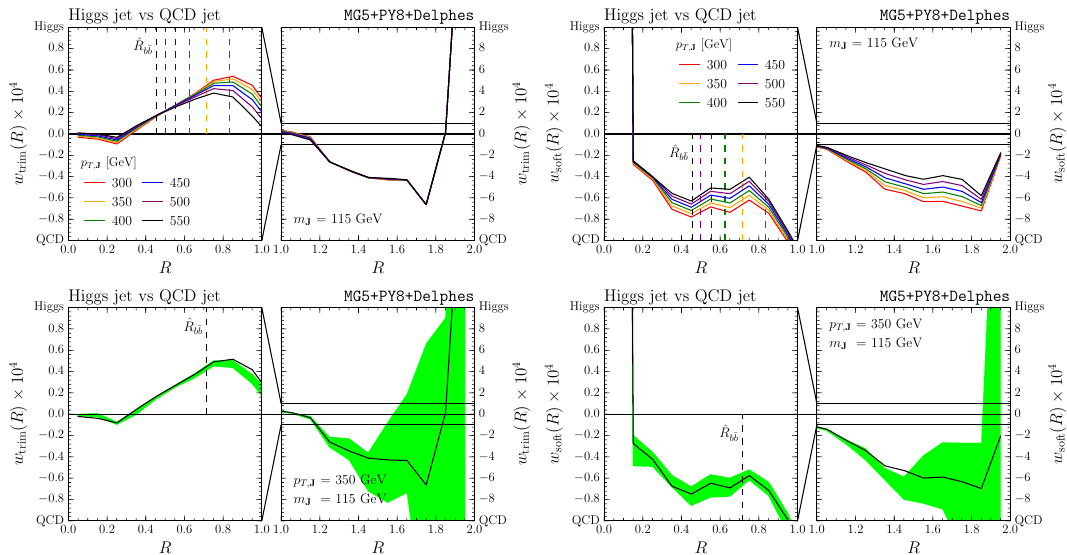
Figure 14 . The weights w trim (left) and w soft (right) of Higgs jet vs. QCD jet classi(cid:12)cation. We show the weights for p T; J values in the range [300 ; 550] GeV while (cid:12)xing the m J to 115 GeV. The weights at an angular scale smaller than 1.0 are magni(cid:12)ed by 10. The value of w soft in the bin [0 ; 0 : 1), i.e., w 0 , is approximately 32 for all the values of p T; J . In the lower panels, we show the soft statistical uncertainty of the weights from the training dataset at p T; J = 350